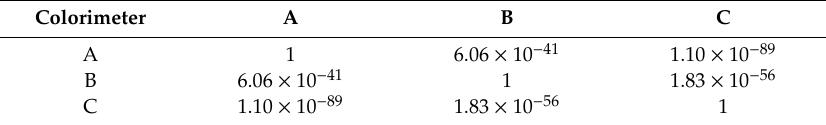
Table 2. T -Test ( p -value) of colorimeter data for study areas (age categories) A, B, C.